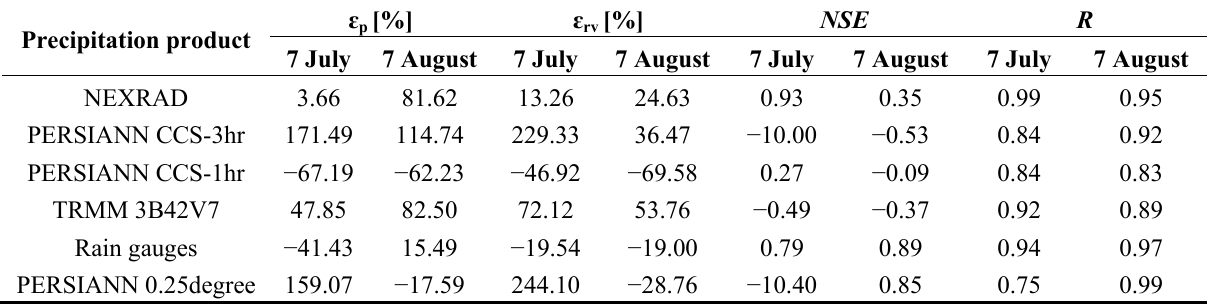
Table 7. Performance evaluation of simulated streamflows driven by different precipitation products (+ve and − ve signs represent the over and underestimation,